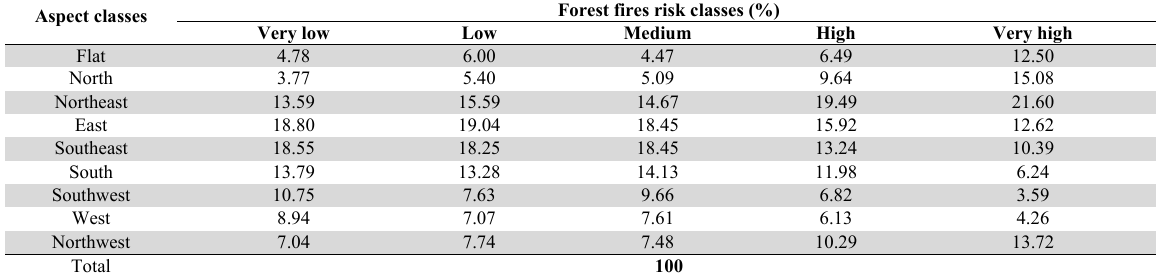
Spatial relationship between forest fires risk classes and aspect in Amojú river basin, Cajamarca region Aspect